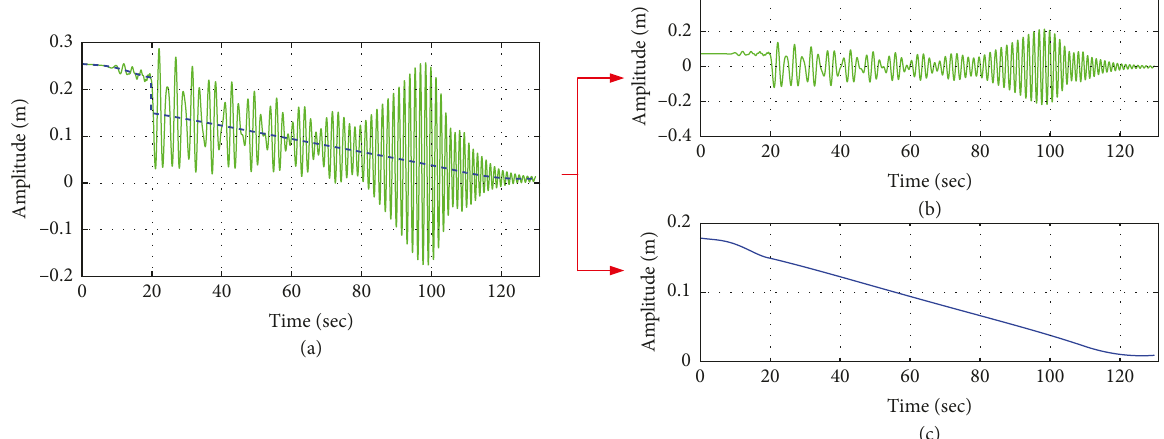
Figure 5: Separation schematic diagram of vibration displacement and elastic displacement. The (a) original signal, (b) vibration dis- placement, and (c) elastic